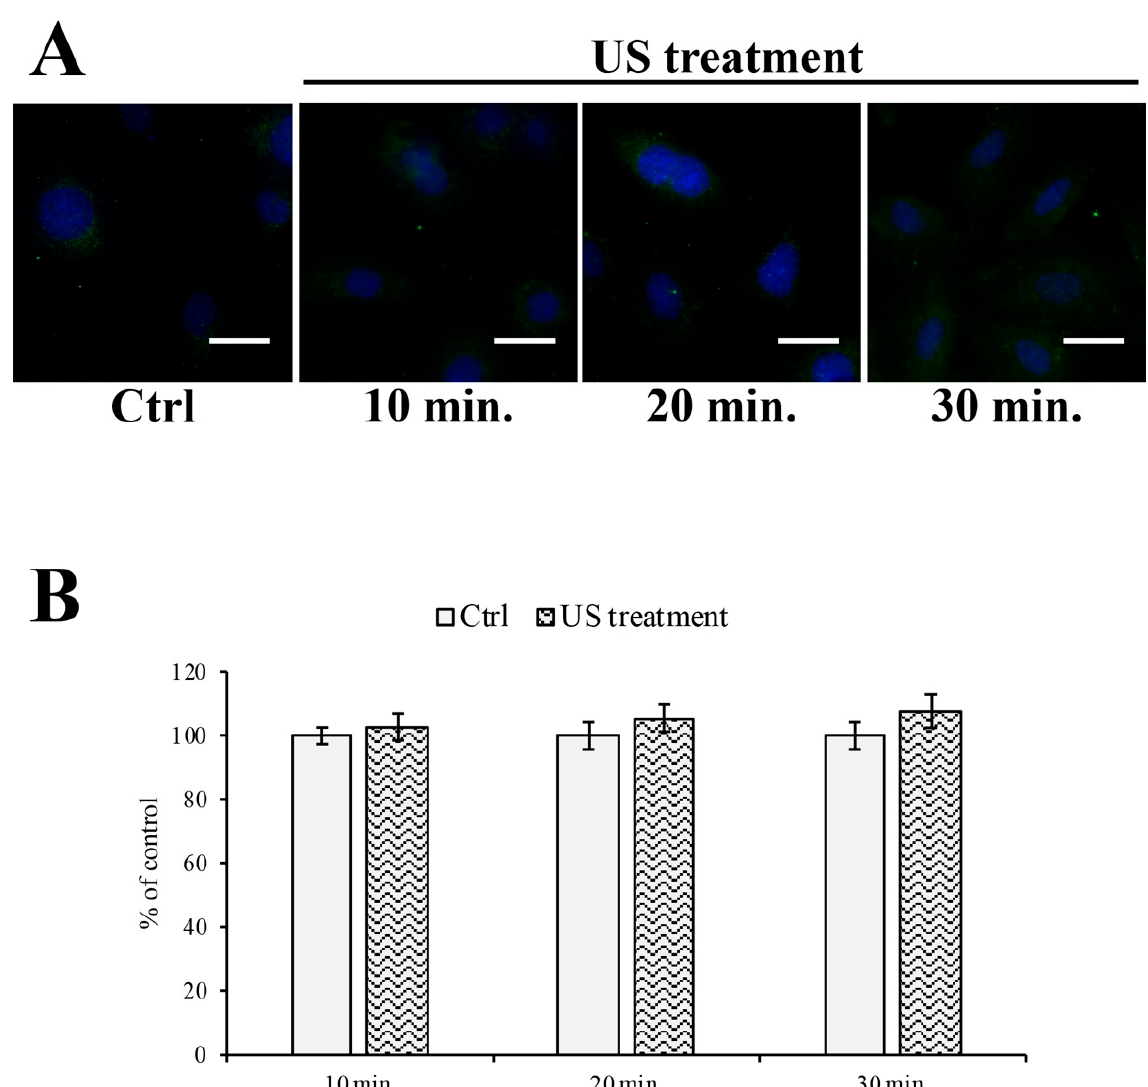
Figure 4. Mitochondrial cytochrome C localization during US treatment. ( A ) Immunofluorescence staining analysis of cytochrome C (green), counterstained with DAPI (blue) during US stimulation for 10, 20, and 30 min, showing a punctate immunostaining pattern of cytochrome C. ( B ) The semi- quantitative analysis of fluorescence levels did not show any differences between the treated samples and the control (untreated cells). Values are reported as percentages of the control (untreated cells), arbitrarily taken as 100%. The results are expressed as the mean ± S.E.M. of three independent experiments, performed in triplicate. Five microscopic fields per treatment have been recorded. Total magnification: 400 × ; scale bar: 25 µm.